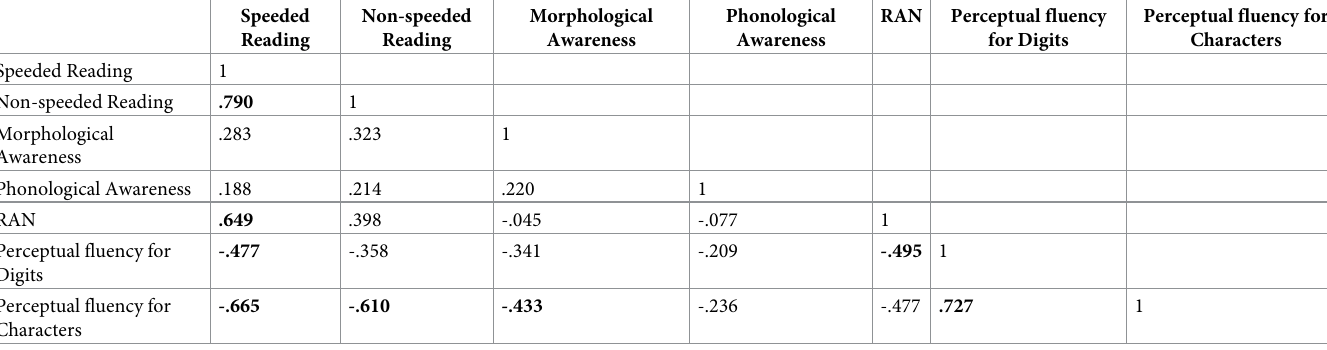
Table 2. Pearson correlation matrix for the speeded and non-speeded reading as well as other component skill